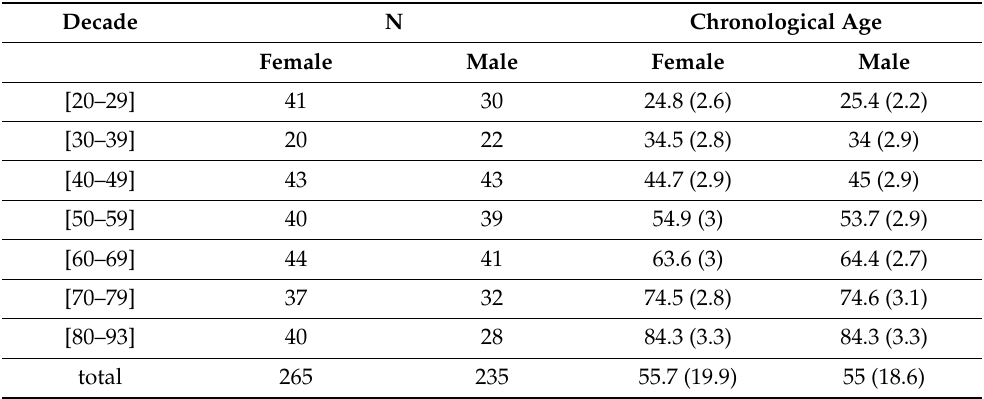
Table 1. Distribution of the population according to sex and chronological age (mean (standard deviation)). The speakers are grouped here in decades but are not grouped in the